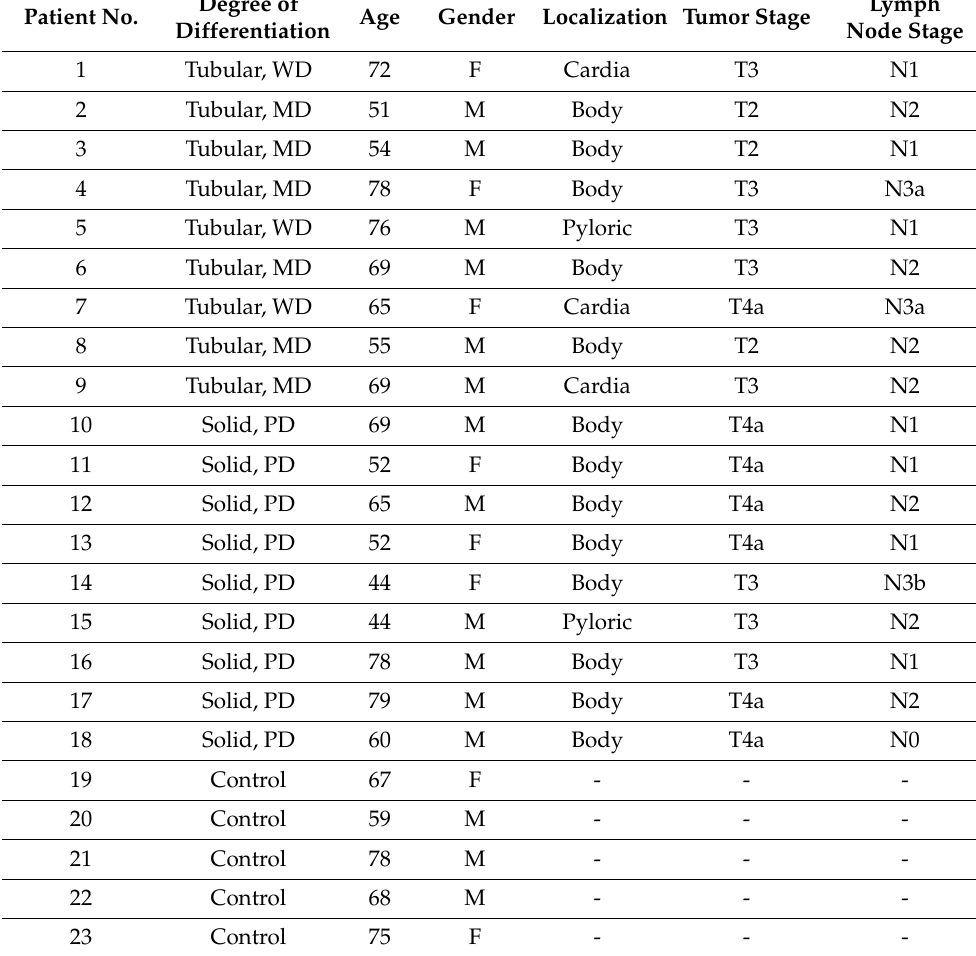
Table 1. Patients included in the